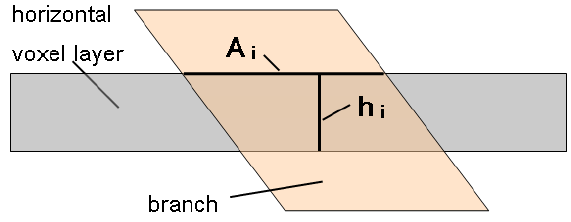
Figure 3. Layer-wise volume estimation by determination of the cross-section area A i of branches multiplied by height h i (=thickness of voxel